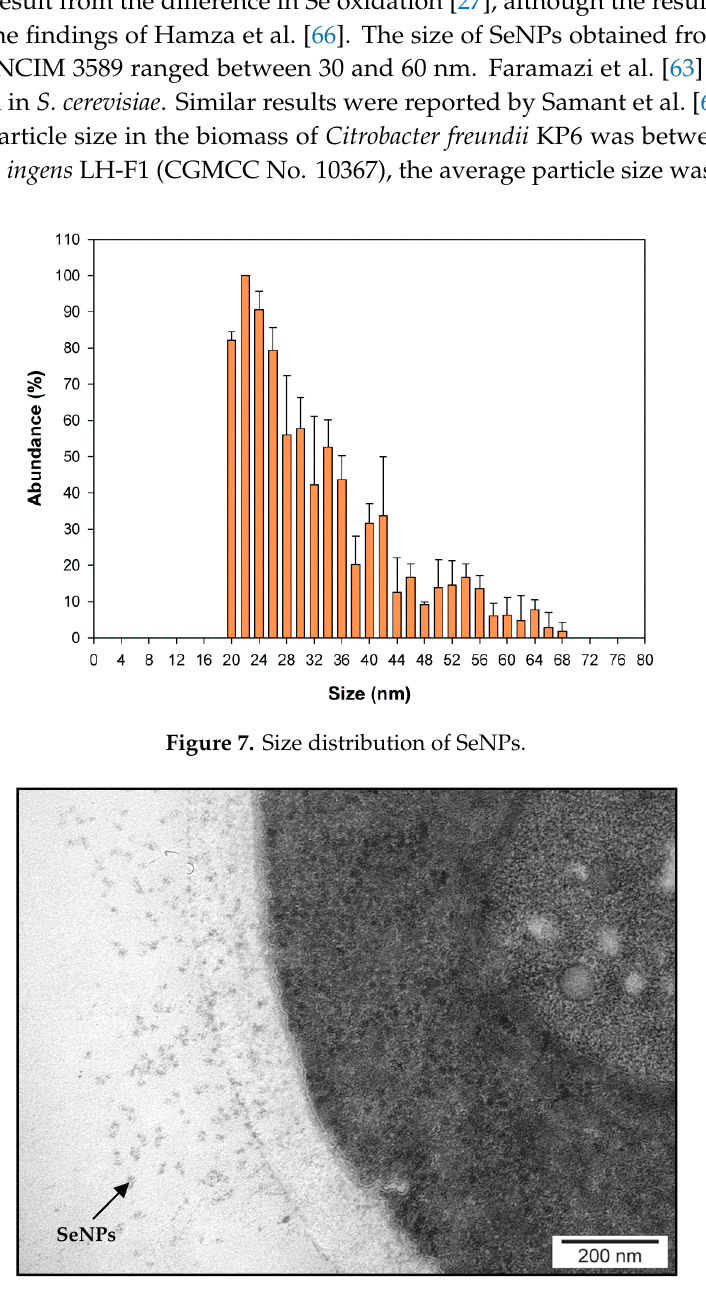
Figure 8. TEM image of SeNPs in yeast cell wall.